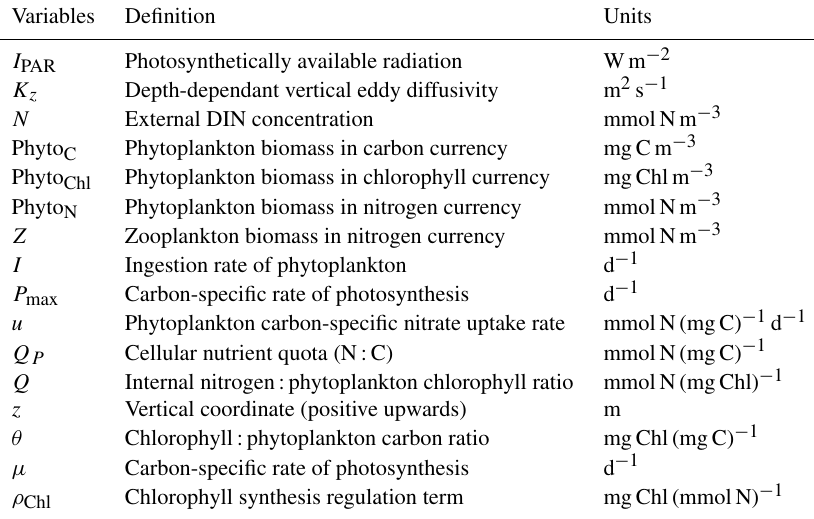
Table A1. List of all variables for the biological part of the S2P3 v8.0 model.